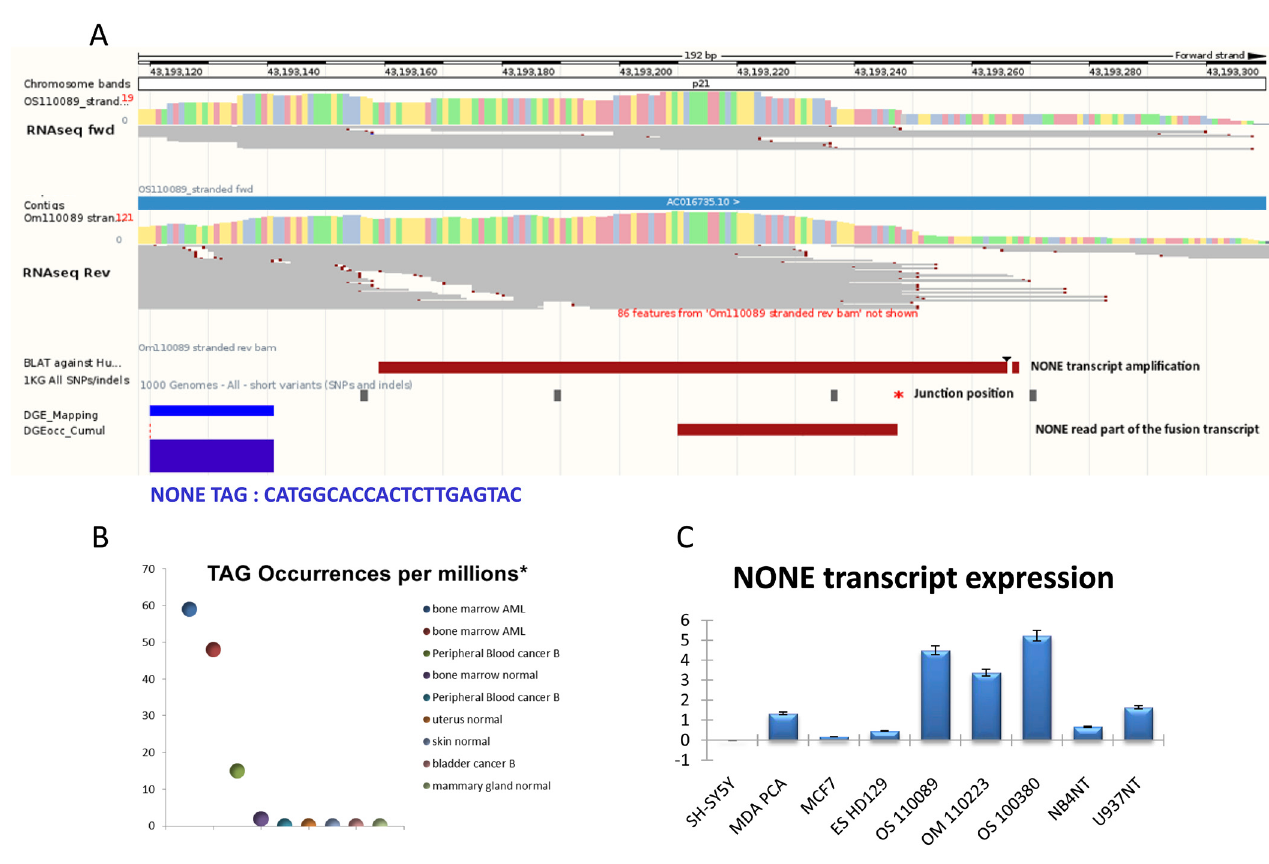
Figure 2. NONE transcript sequencing and expression. A ) Display of the ENSEMBL genome browser viewer for the NONE transcribed region. The blue horizontal bars represent the genomic sequence. The histogram of the RNA-Seq coverage in the chromosomal region is displayed on both strands (OS110089 stranded and RNA-seq fwd/rev tracks). Public and personal DGE data (‘DGE tag location’ track: blue rectangle for occurrence>2) are displayed on both strands of the chromosome, with their relative occurrences (histogram of ‘DGE